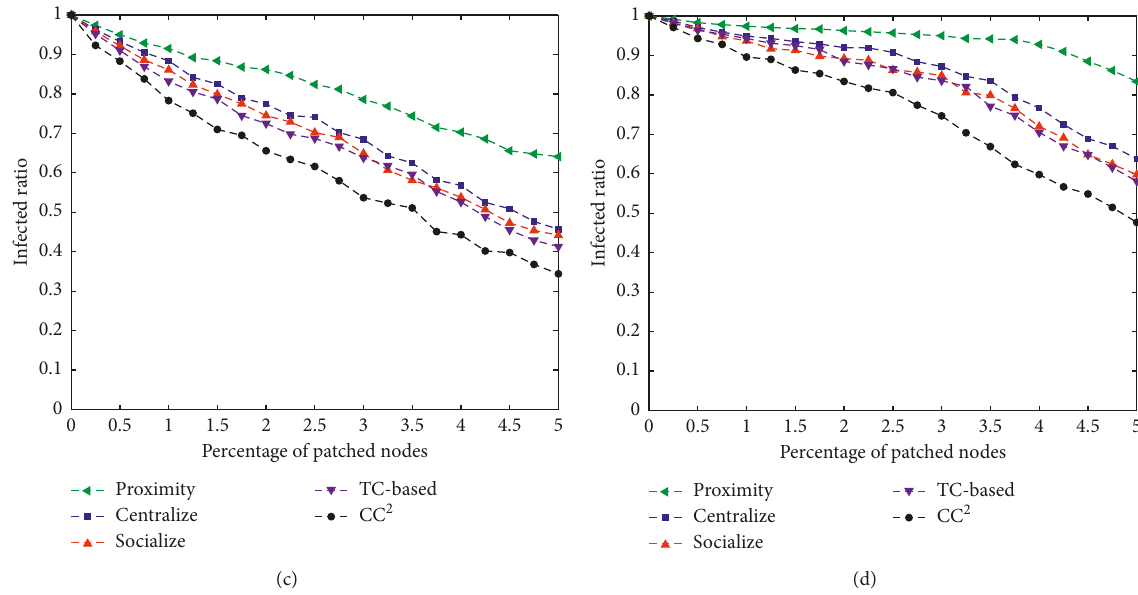
Figure 10: Performance comparison of different patching strategy on the Haggle network with an initially infection ratio μ � 5% (a), 10% (b), 15% (c), and 20% (d),